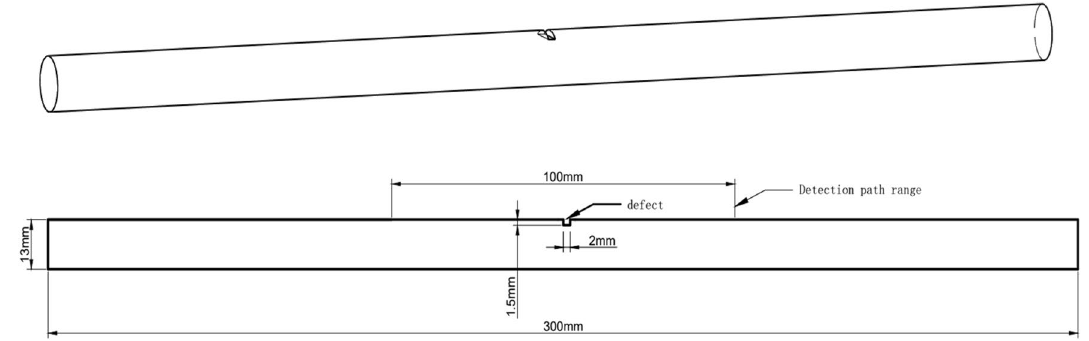
Fig. 4 Three-dimensional view and overall size of cylindrical 60 steel specimen and detection path range of magnetic memory signal